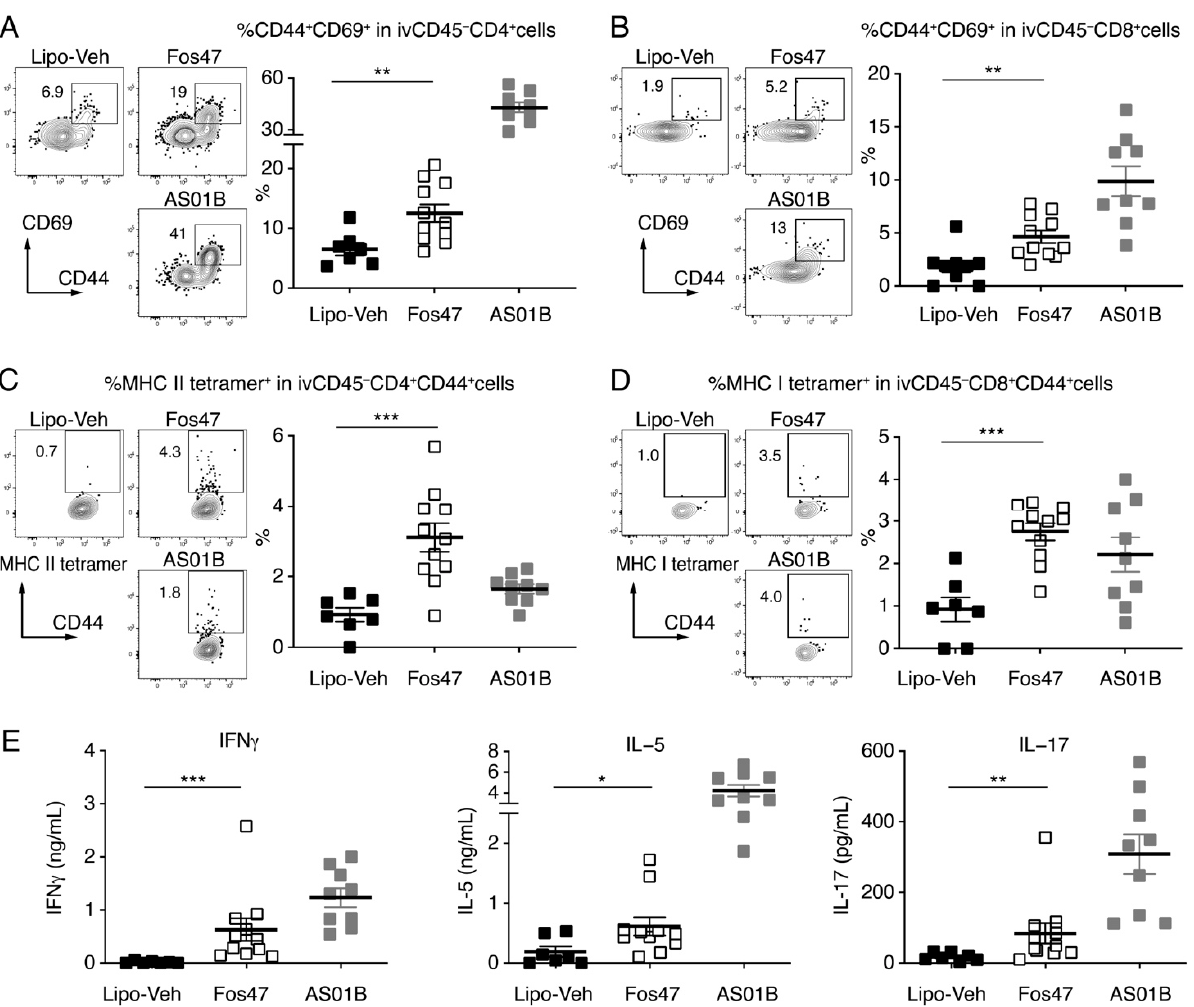
Figure 3. IN boosting with Fos47 enhanced antigen-specific T cell responses in the lung. Female BALB/c mice ( n = 7–11/group) were immunized with IIAV adjuvanted with Lipo-Veh, Fos47 or AS01B by IM-IN-IN regimen on days 0, 21 and 28, and on day 35 lung cells were isolated and analyzed by flow cytometry. Non-circulating tissue-resident cells in the lung were identified by iv staining with anti-CD45 antibody. Non-circulating (ivCD45 – ) CD4 + and CD8 + cells were analyzed for CD44 + CD69 + memory T cells. ( A ) %CD69 expressing CD44 + in ivCD45 – CD4 + and ( B ) ivCD45 – CD8 + T cells are presented. ( C , D ) ivCD45 – CD4 + CD44 + ( C ) and ivCD45 – CD8 + CD44 + ( D ) memory T cell subsets were further analyzed using MHC class II tetramer and MHC class I tetramer reagents by flow cytometry. ( E ) Splenocytes were isolated on day 35 and restimulated ex vivo with 10 μ g/mL HA [A/California/04/2009(H1N1)] protein for 3 days. IFN γ , IL-5 and IL-17 secreted in the supernatants were evaluated by ELISA. Pooled data from two independent experiments are presented. Bars indicate means ± SEM. * p < 0.05, ** p < 0.01, *** p < 0.001, two-tailed Mann–Whitney U -test to compare IN-Lipo-Veh and IN-Fos47.